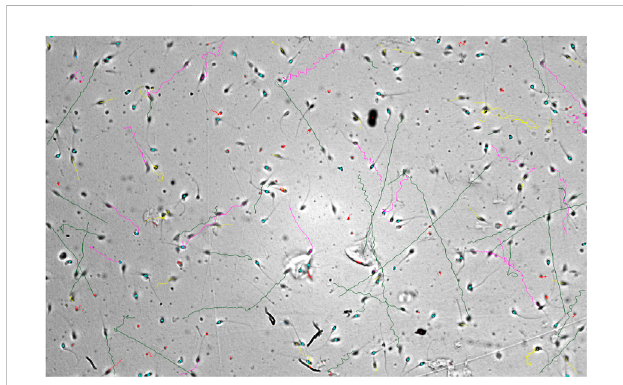
FIGURE 2 (Right) Frames recorded from the CASA analysis on sperm cells withoutAMLEusingMMCsoftware.Thered,yellow,andblackstreaksare produced by the MMC softwarewhich recognizes the motility of active and progressive motility.